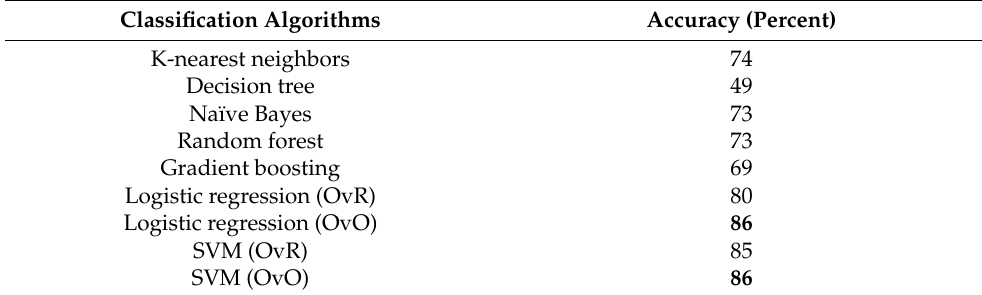
Table 5. Face recognition accuracy comparison on different classifiers.